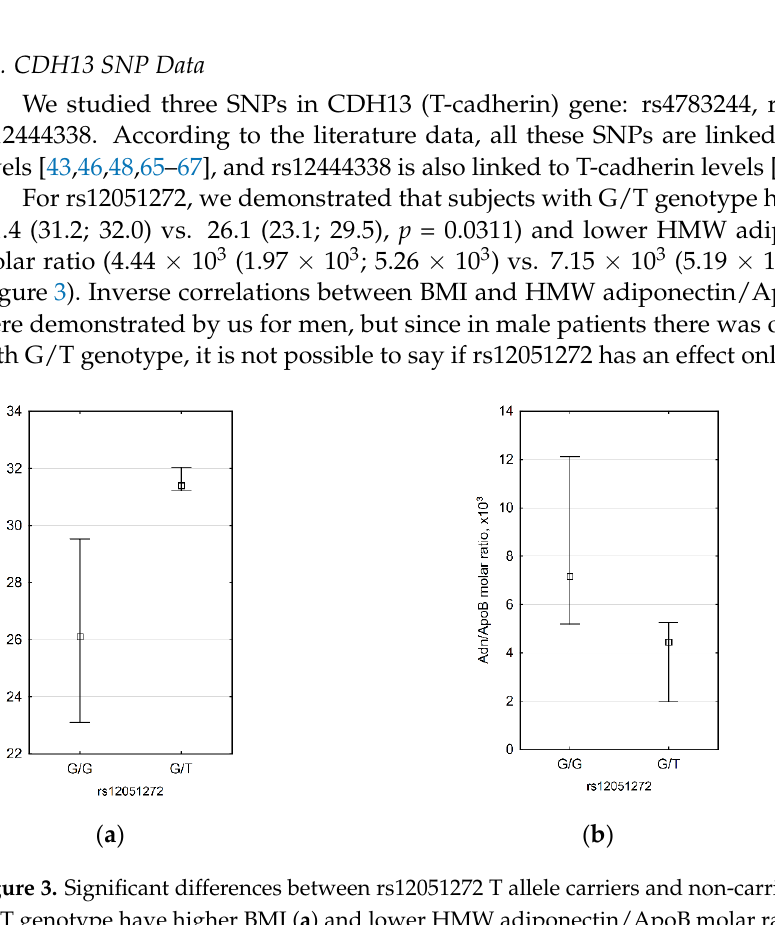
Figure 2. Association between presence of AH and ( a ) plasma LDL level ( p = 0.609), ( b ) plasma ApoB level ( p = 0.668), ( c ) plasma HMW adiponectin level ( p = 0.779), ( d ) plasma T-cadherin level (0.181), ( e ) HMW adiponectin/LDL molar ratio (0.961), and ( f ) HMW adiponectin/ApoB molar ratio ( p = 0.779). n = 35 for all diagrams.